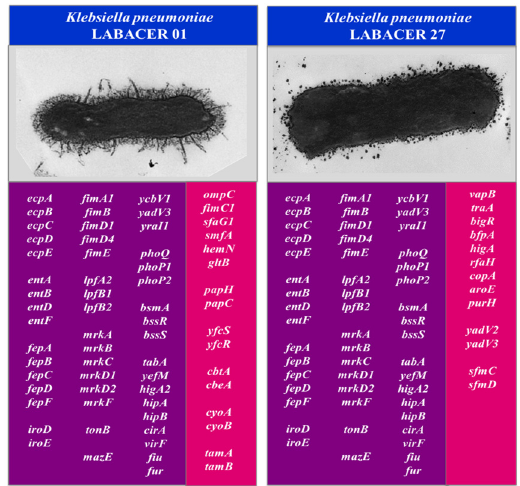
Figure 12. Virulence factor genes found in KPC-2-producing hypermucoviscous ST25 Klebsiella pneumoniae strains LABACER 01 and LABACER 27. The genes in the purple boxes are shared between the two LABACER strains as well as with other hypermucoviscous and hypervirulent K. pneumoniae strains (28876, SWU01, whw, ATCC 43816, NTUH-K2044, and RJF293). The genes in the pink boxes were detected only in the indicated LABACER strain.